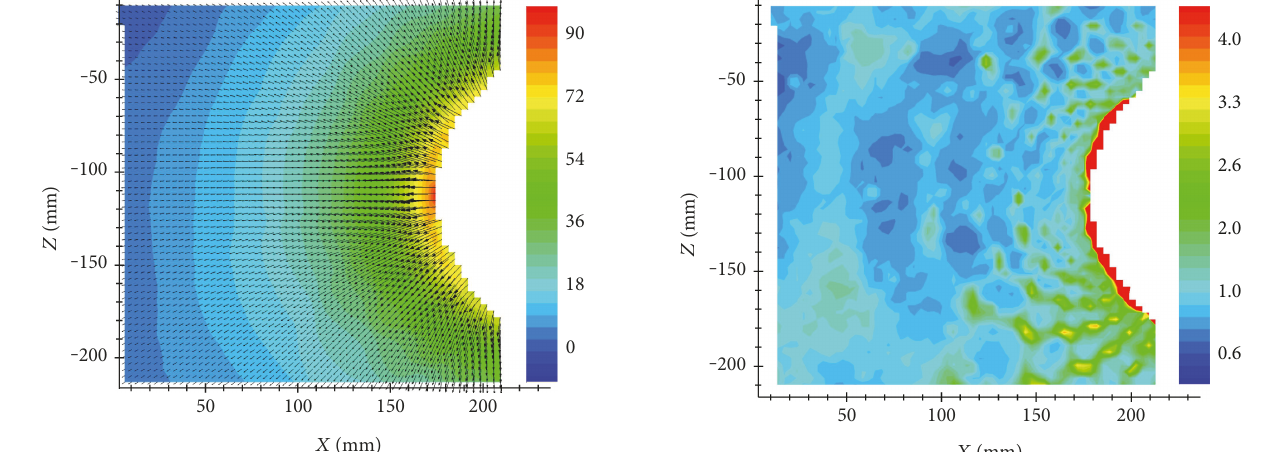
Figure 5: 2D map of the standard deviation of the 50 fl ow fi eld measurements for airfoil velocity equal to